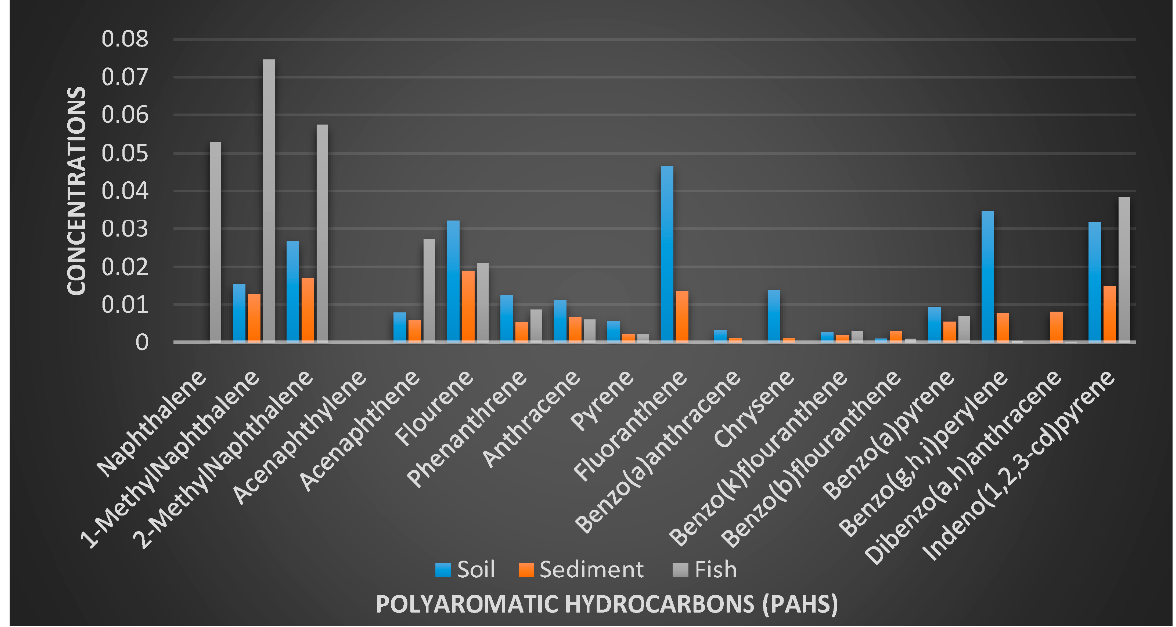
Figure 7. Concentrations ( µ g/kg) of the polycyclic aromatic hydrocarbons (PAHs) in the samples.